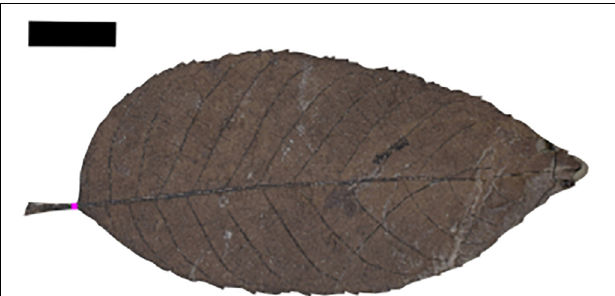
FIGURE 2 | An example of leaf dry mass per area (LMA) estimation. Petiole width (0.07 cm) was measured at the pink line; leaf area (12.3 cm 2 ) was estimated with a conservative reconstruction of the leaf apex. LMA = 60.5 g/m 2 . Morphotype DB396, EPI 53397. Baptist Road DMNH 2177 (65.7 Ma). Scale bar = 1 cm.